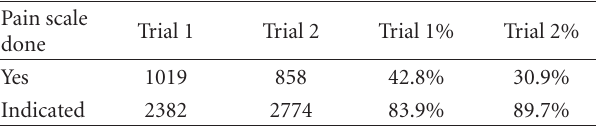
Table 4: Pain scale performance when indicated by chief